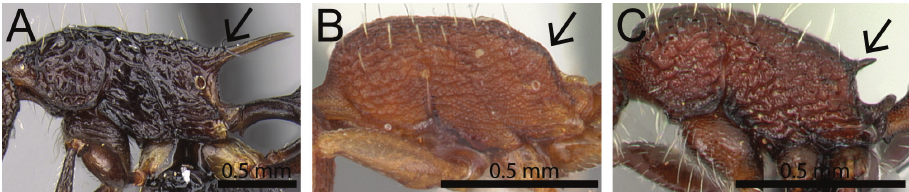
Figure 5. Mesosoma in profile (black arrows indicate propodeal spines/teeth area). A T. tosii (CASENT0249662) B T. anodontion (CASENT0102334) C T. mahafaly (CASENT0449159). 6 Head in full-face view relatively thin (CI < 80) and antennal scapes very long (SI > 120) (Fig. 6A); in general appearance head, antennae, and legs elongate and slender (Fig. 6E) ..................................................... T. setigerum group – Head in full-face view relatively thicker (CI > 85) and antennal scapes con- spicuously much shorter (SI < 92) (Fig. 6B, C, D); in general appearance more compact species with thicker heads and shorter antennae and legs